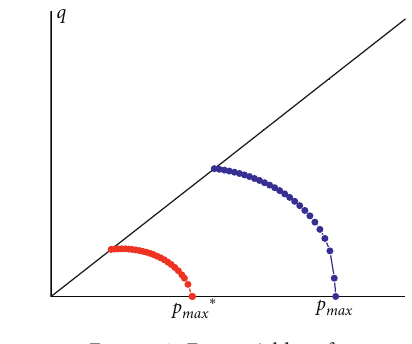
Figure 3: Fuzzy yield surface.